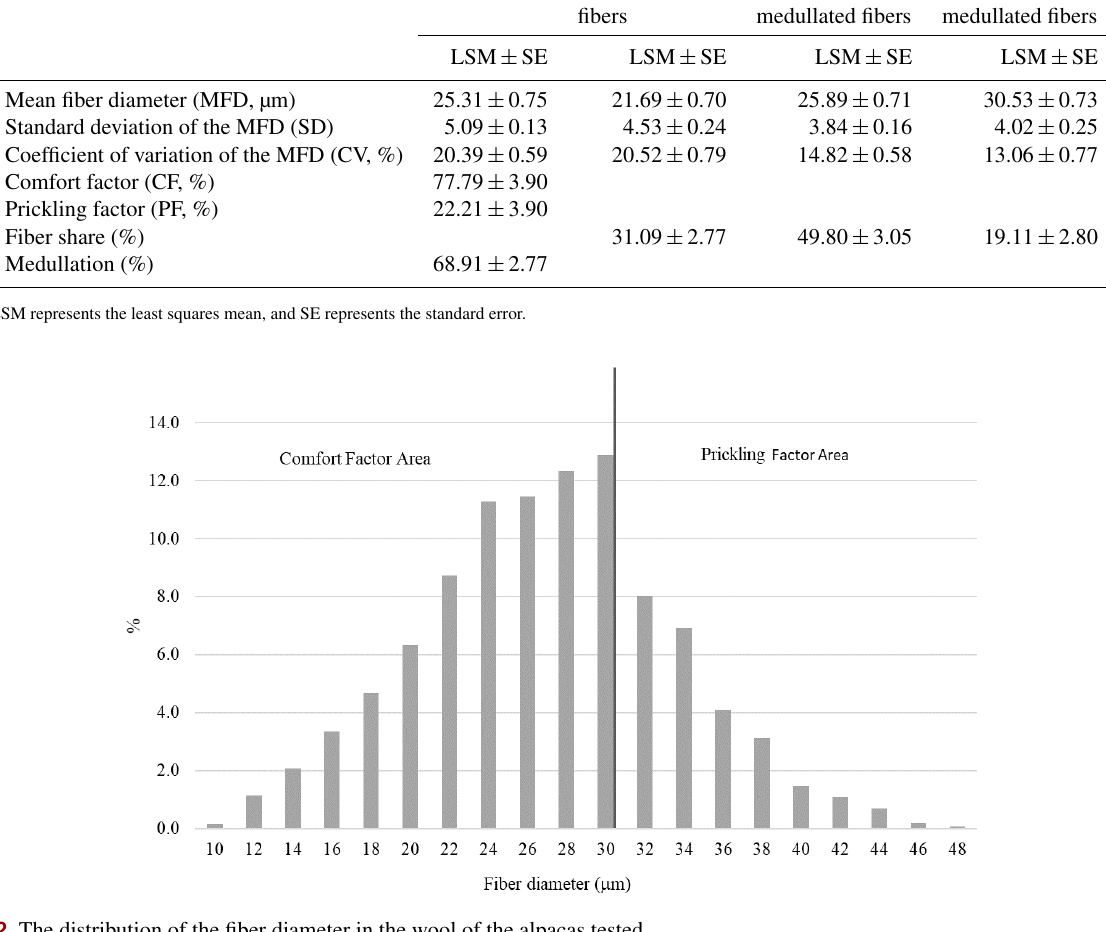
Table 1. The overall characteristics of wool thickness and the medullation features of the alpacas investigated. Item